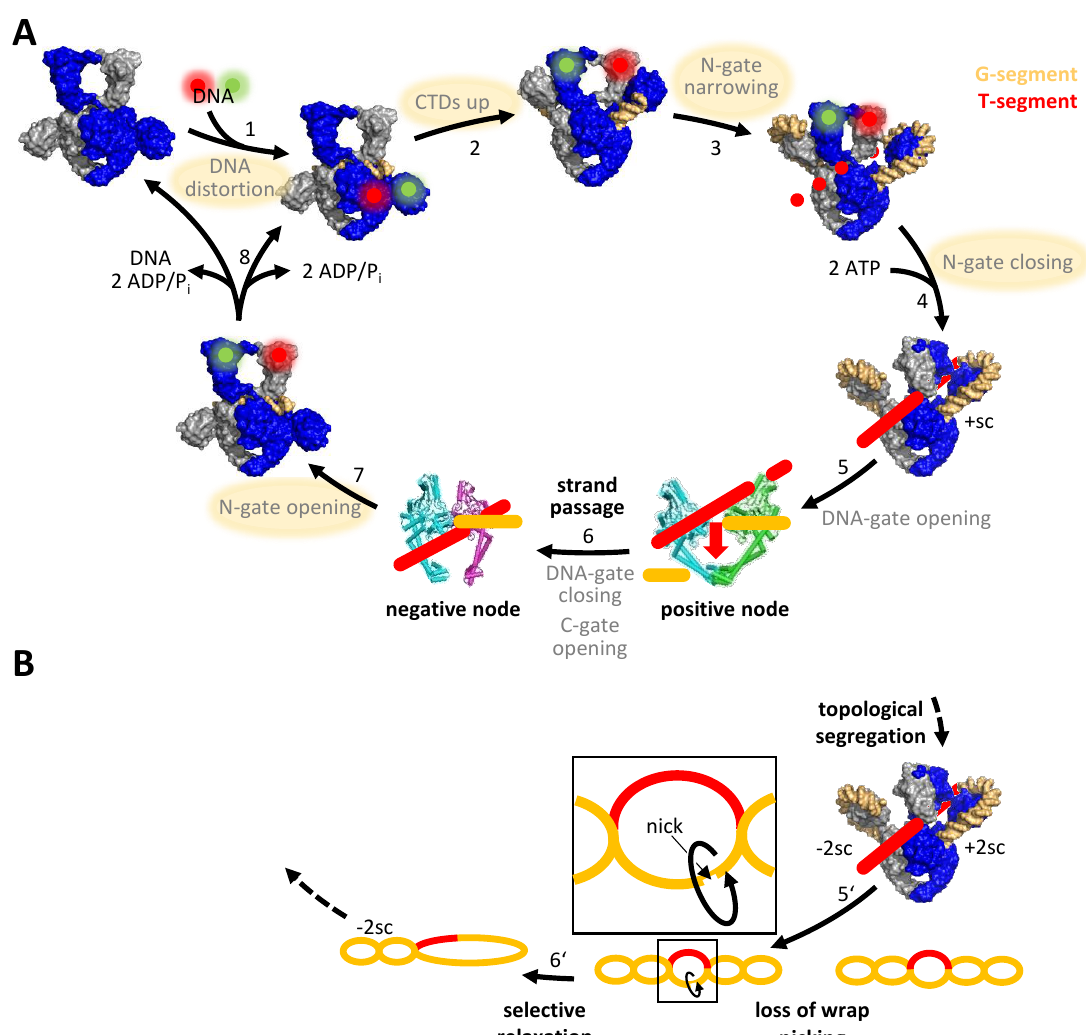
Figure 5. Conformational changes in the catalytic cycle of gyrase. ( A ) Conformational changes during DNA supercoiling by gyrase, as delineated by single-molecule FRET. Green, red: donor- and acceptor fluorophores for FRET experiments. One GyrA and GyrB subunit is shown in blue, the second in gray. Green and red spheres denote the position of donor and acceptor fluorophores to probe conformational changes of the DNA (1), the position of the CTD (2), or the conformation of the N-gate (3, 4, 7). Conformational changes detected by FRET are highlighted in yellow. The other conformational changes indicated, i.e., opening and closing of the DNA- and C-gates, have been postulated but were not yet observed by FRET. Crystal structures of GyrA in which one of the gates is open illustrate that opening of these gates is possible in principle. According to the strand-passage model, strand passage (6) converts a positive node into a negative node, decreasing the linking number of the DNA by two. Figure from https://www.mdpi.com/1422-0067/19/5/1489, accessed on 3 February 2021. ( B ) Gyrase with a single catalytic tyrosine catalyzes DNA supercoiling in the absence of strand passage in steps of two. This enzyme undergoes the same cascade of DNA- and nucleotide-induced conformational changes as does wild-type gyrase, i.e., DNA distortion, DNA-dependent movement of the CTD, narrowing of the N-gate, and ATP-dependent closing of the N-gate (steps 1–4 in panel ( A )). DNA supercoiling in the absence of double-strand cleavage and strand passage can be rationalized by the capture of two positive supercoils, followed by topological segregation and selective relaxation of these supercoils (steps 5 and 6). Selective relaxation is brought about by nicking and rotation of the DNA around the phosphodiester bonds in the contiguous, non-cleaved strand (inset). Afterwards, ATP hydrolysis, N-gate opening and product release (steps 7, 8 in panel ( A )) reset gyrase for further catalytic cycles. Only the steps deviating from the strand-passage mechanism shown in panel ( A ) are depicted. As the structural basis for the capture of two supercoils by gyrase is unknown, the schematic shows only the DNA sketch. +sc: positive supercoil, +2 sc: two positive supercoils, − 2 sc: two negative supercoils, CTD: C-terminal